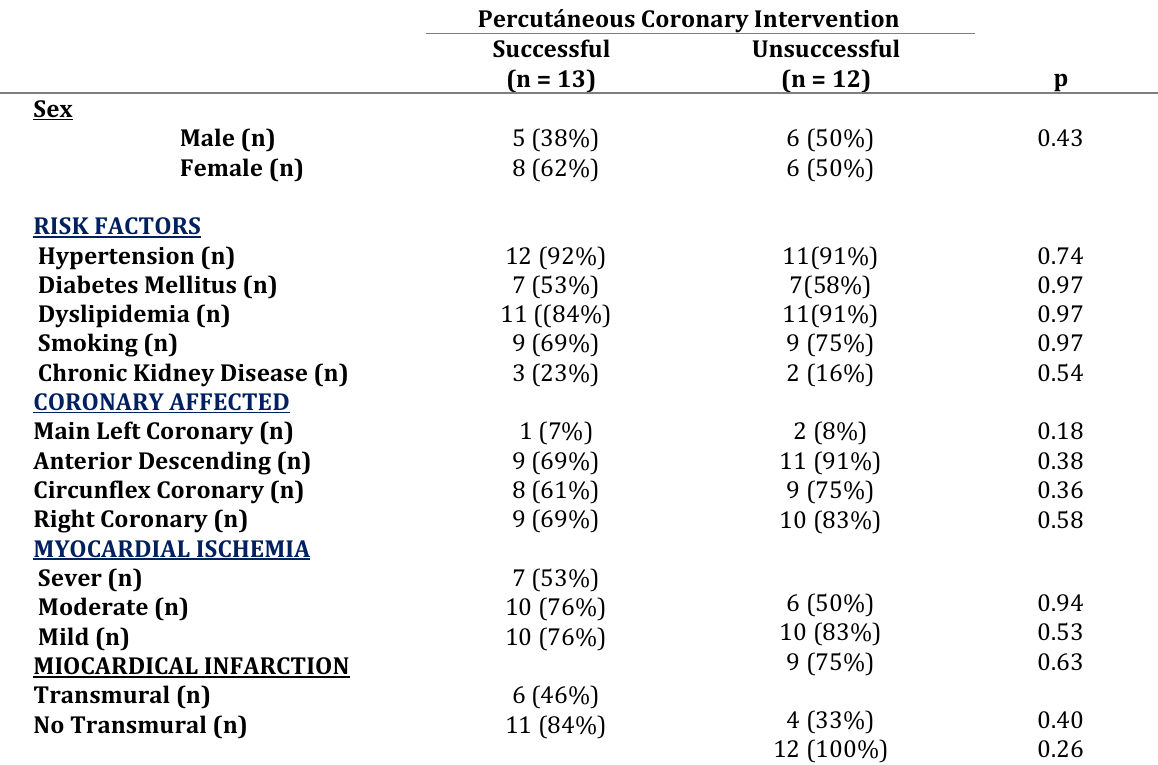
P-Value was calculated with chi-squared